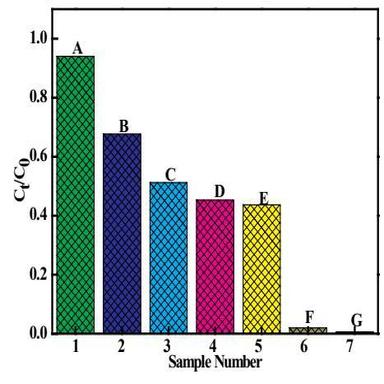
Adsorption/degradation tests of P-chlorophenol.